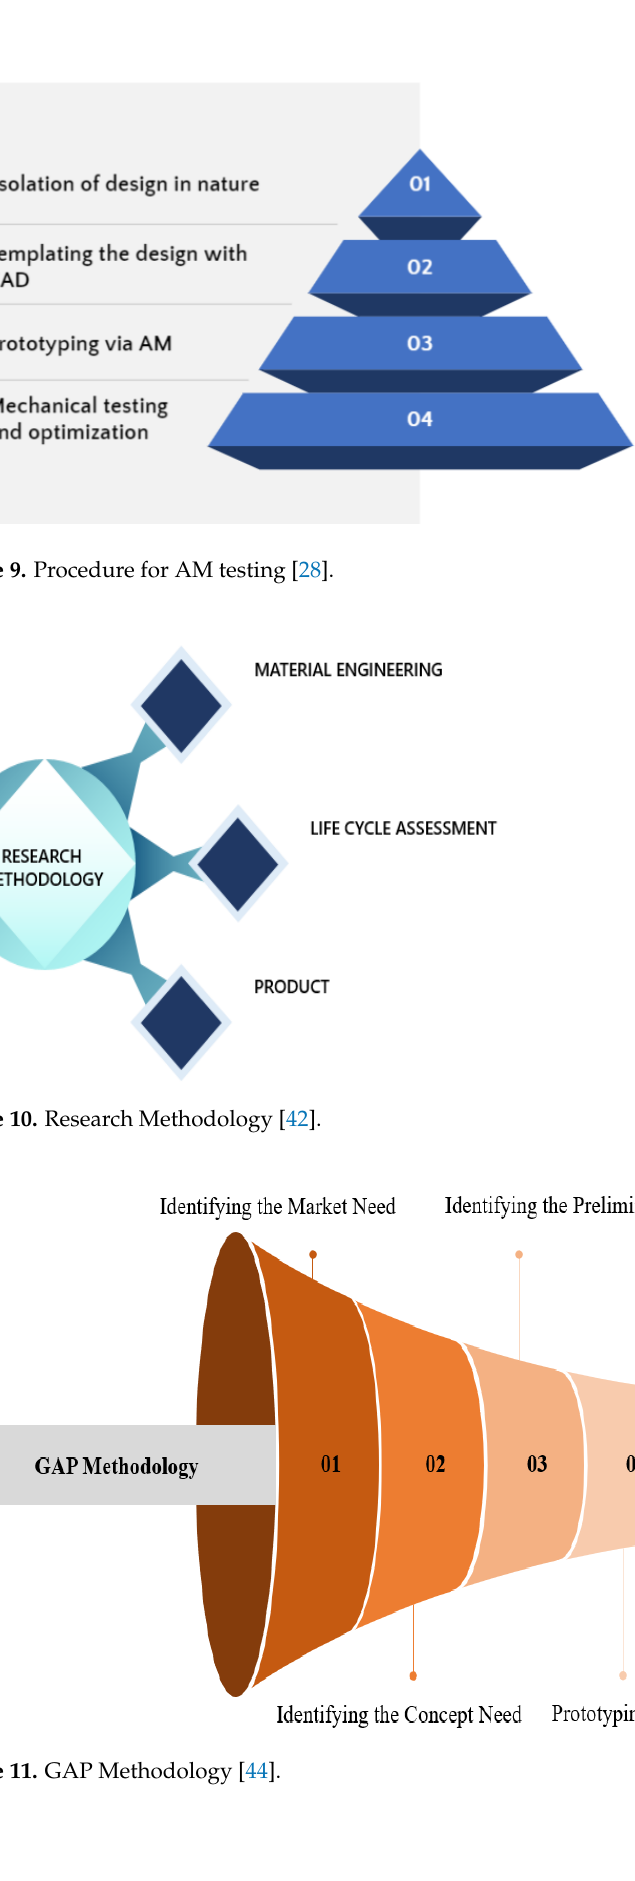
Figure 11. GAP Methodology [44]